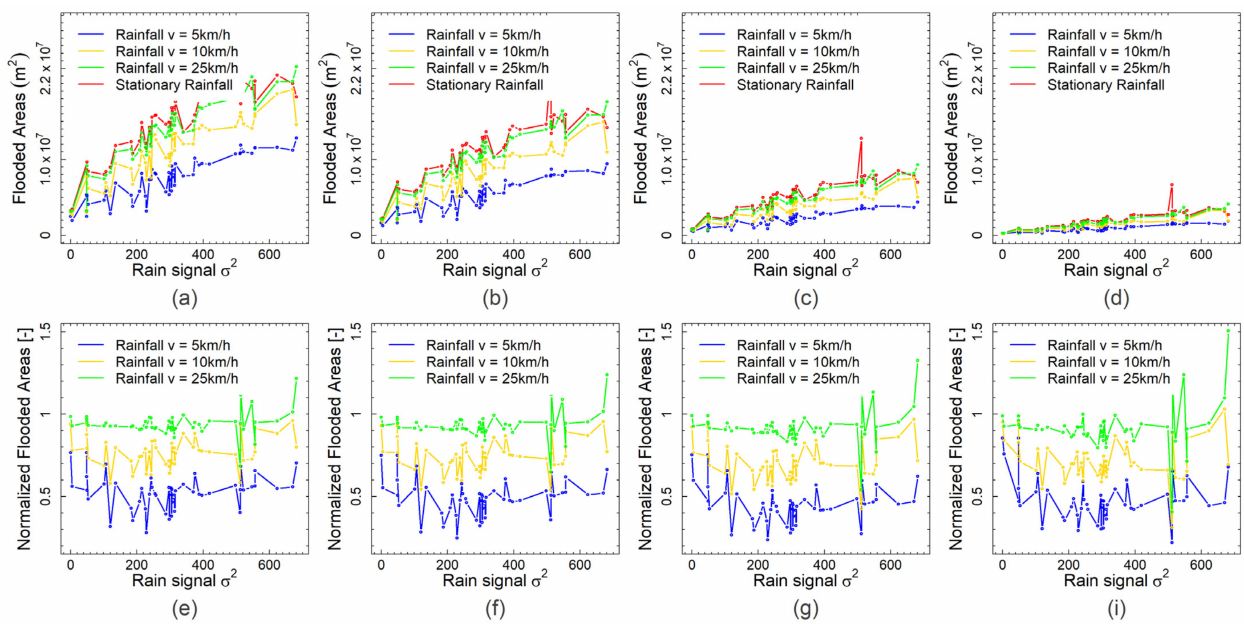
Figure 11. Flooded areas ( a – d ) in the two lower floodplains for all rains in the stationary setup and moving setups with velocities v = 5 km/h, v = 10 km/h, v = 25 km/h with a movement direction from west to east. ( e – i ) present the flooded areas of the moving setups normalized by the flooded area of the stationary scenario. Figures from left to right represent water levels above 10 cm, 20 cm, 50 cm and 100 cm